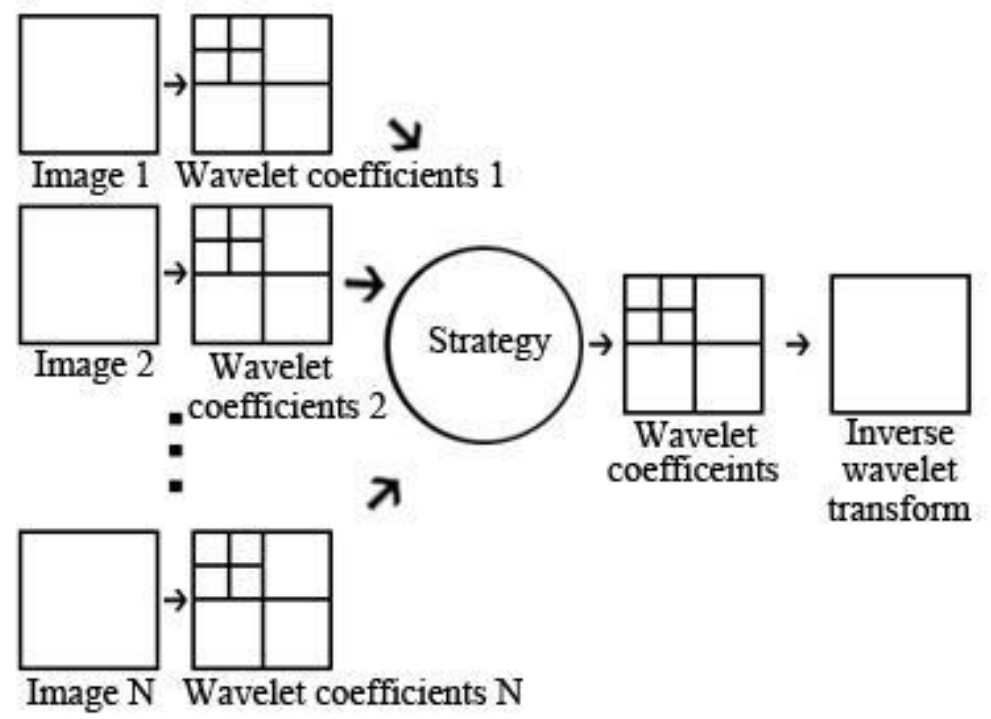
Fig.6. flow of wavelet